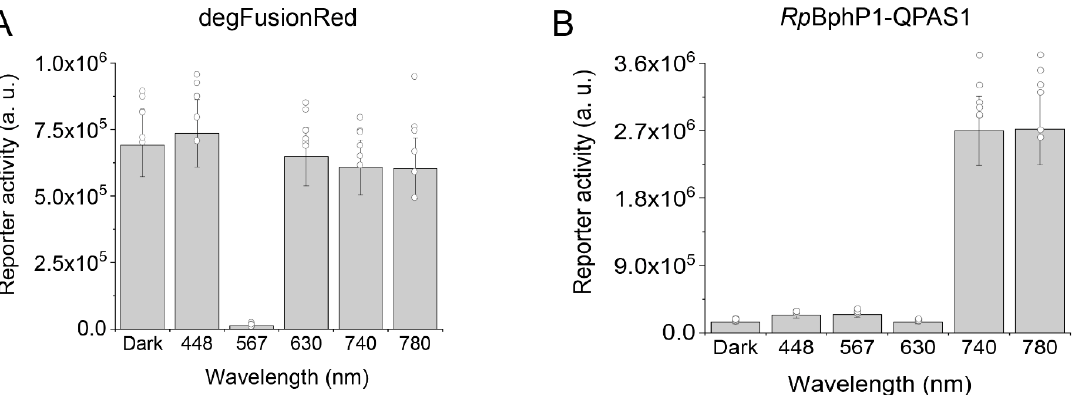
Figure 4. Spectral sensitivity of degFusionRed and Rp BphP1 ‐ QPAS1 optogenetic systems. ( A ) Performance of Gal4 ‐ degFusionRed ‐ p65 transcription factor in HEK293 cell under 448 nm, 567 nm, 630 nm, 740 nm and 780 nm light determined by the activity of cotransfected luciferase reporter construct depicted in Figure 1A (bottom). ( B ) Performance of Rp BphP1 ‐ VP16 and Gal4 ‐ QPAS1 heterodimerizing optogenetic pair in HEK293 cell under 448 nm, 567 nm, 630 nm, 740 nm and 780 nm light determined by the activity of cotransfected luciferase reporter construct depicted in Figure 1A